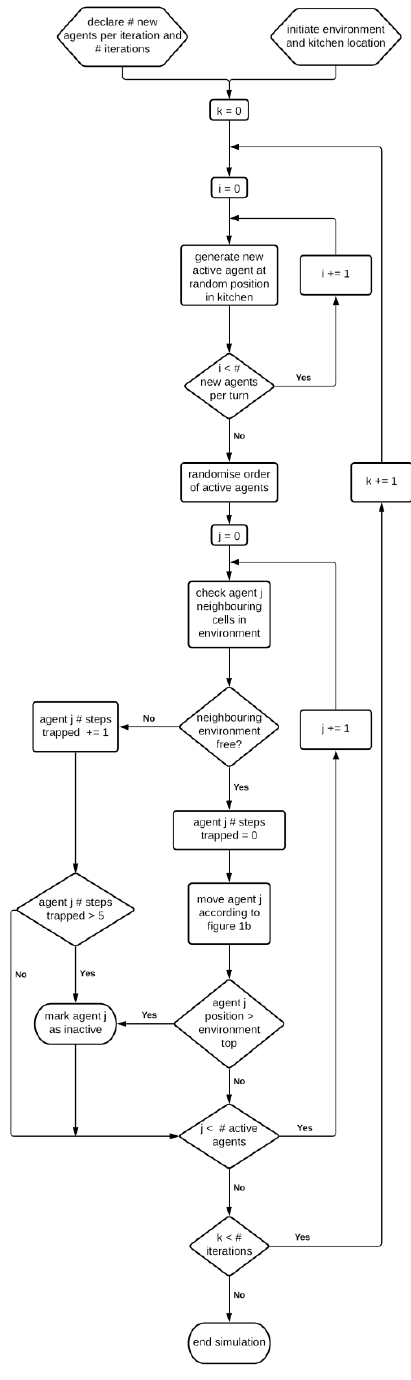
Figure A1. Flow chart showcasing the workings of the Go with the Flow algorithm. The iterators i, j, k are responsible for the generation of new agents, the movement of active agents and the number of iterations to run, respectively.